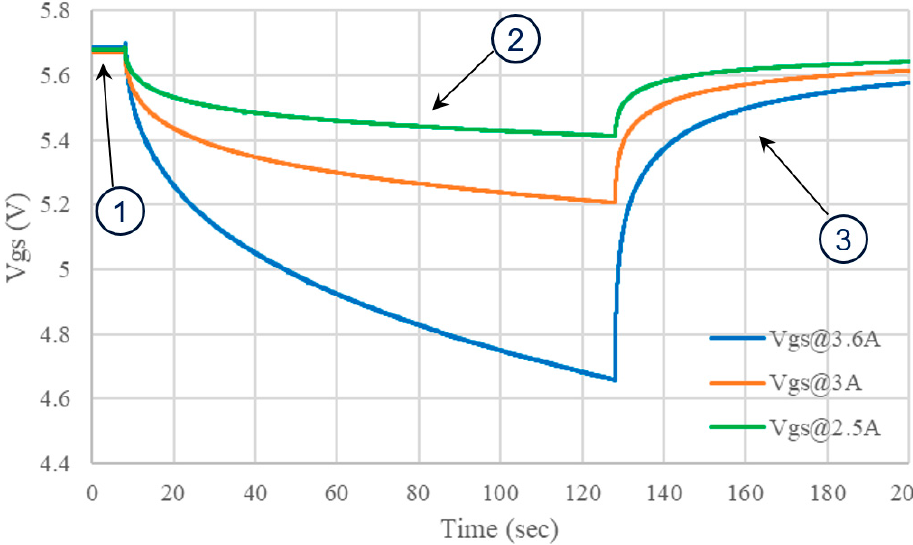
Figure 13. Trend of V gs.